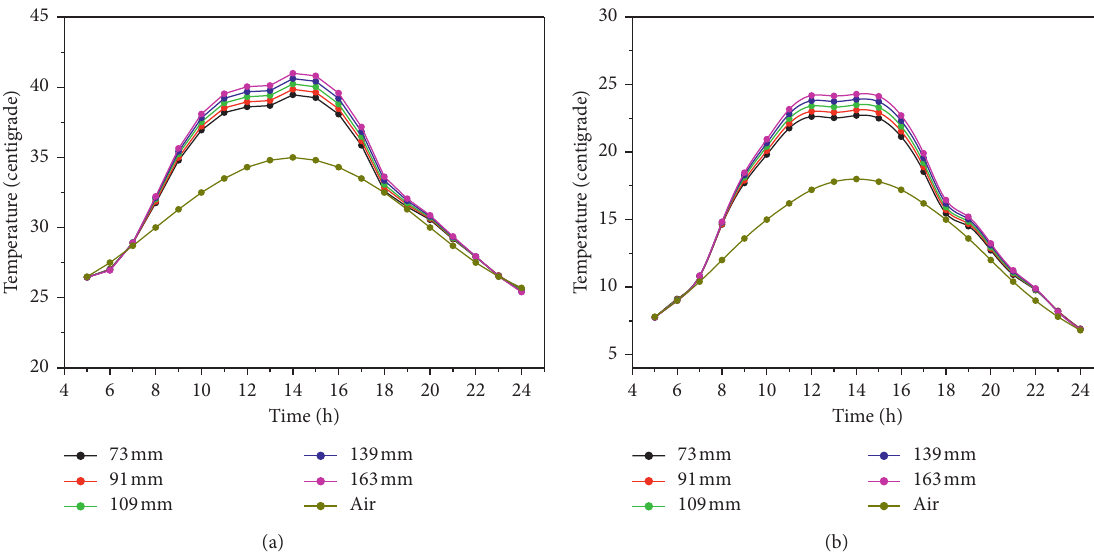
Figure 9: The temperature variation of stay cables. (a) The temperature variation of stay cables in summer. (b) The temperature variation of stay cables in winter.